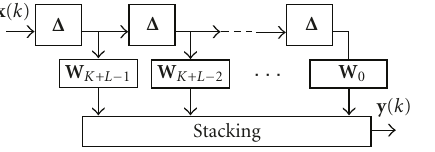
Figure 2: Precoder structure for a frequency-selective fading chan- nel with L independent e ff ective paths.